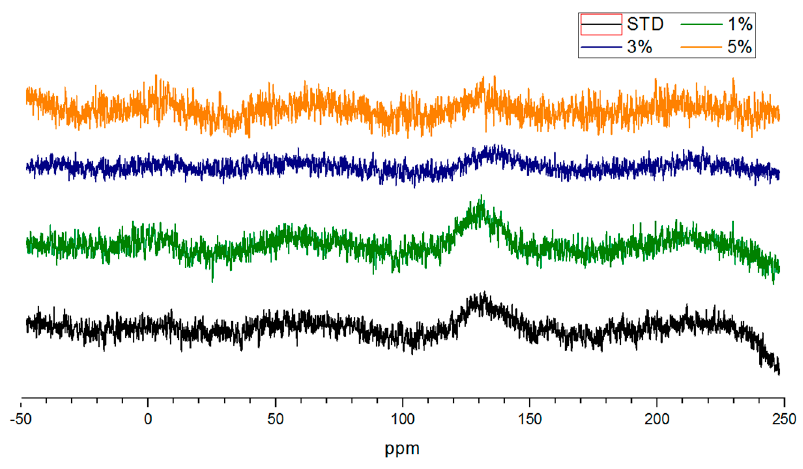
Figure 9. The NMR result of biochar pyrolyzed at 300 °C before and after flushing.